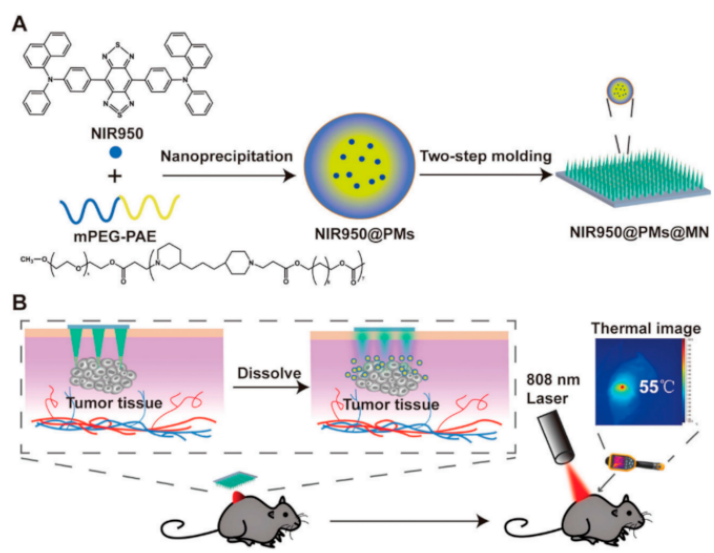
Figure 6. ( A ) Schematic illustration of the synthesis process of NIR950@PMs and NIR950@PMs@MN. ( B ) Schematic illustration of NIR950@PMs@MN application method in the photothermal treatment of tumor-bearing mice. Reproduced with permission from